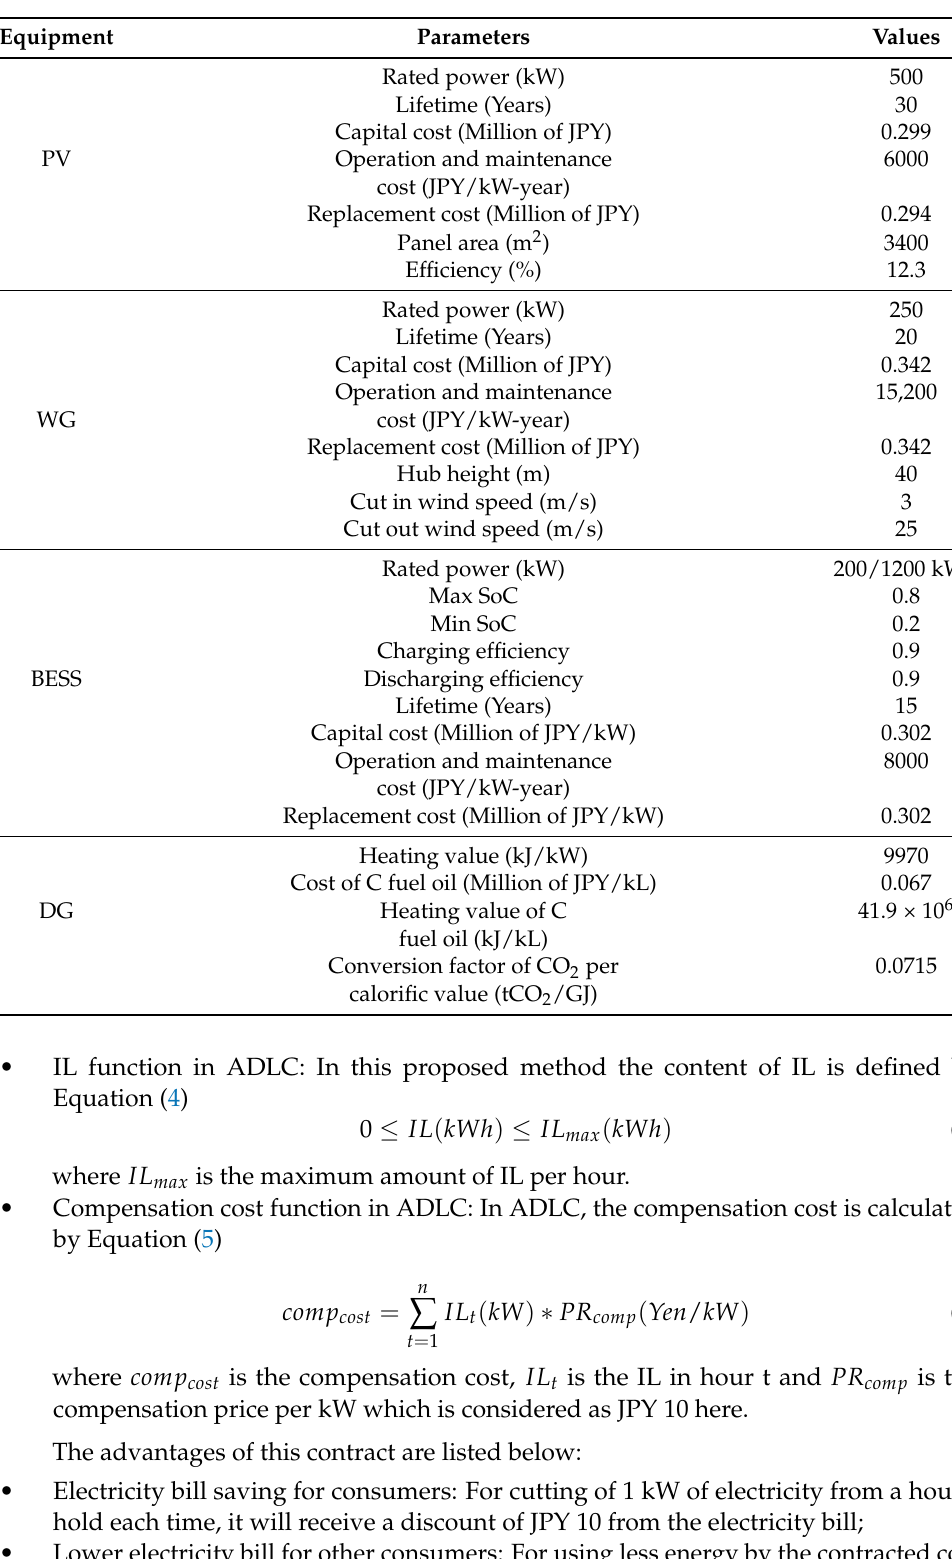
Table 1. Parameters of installed